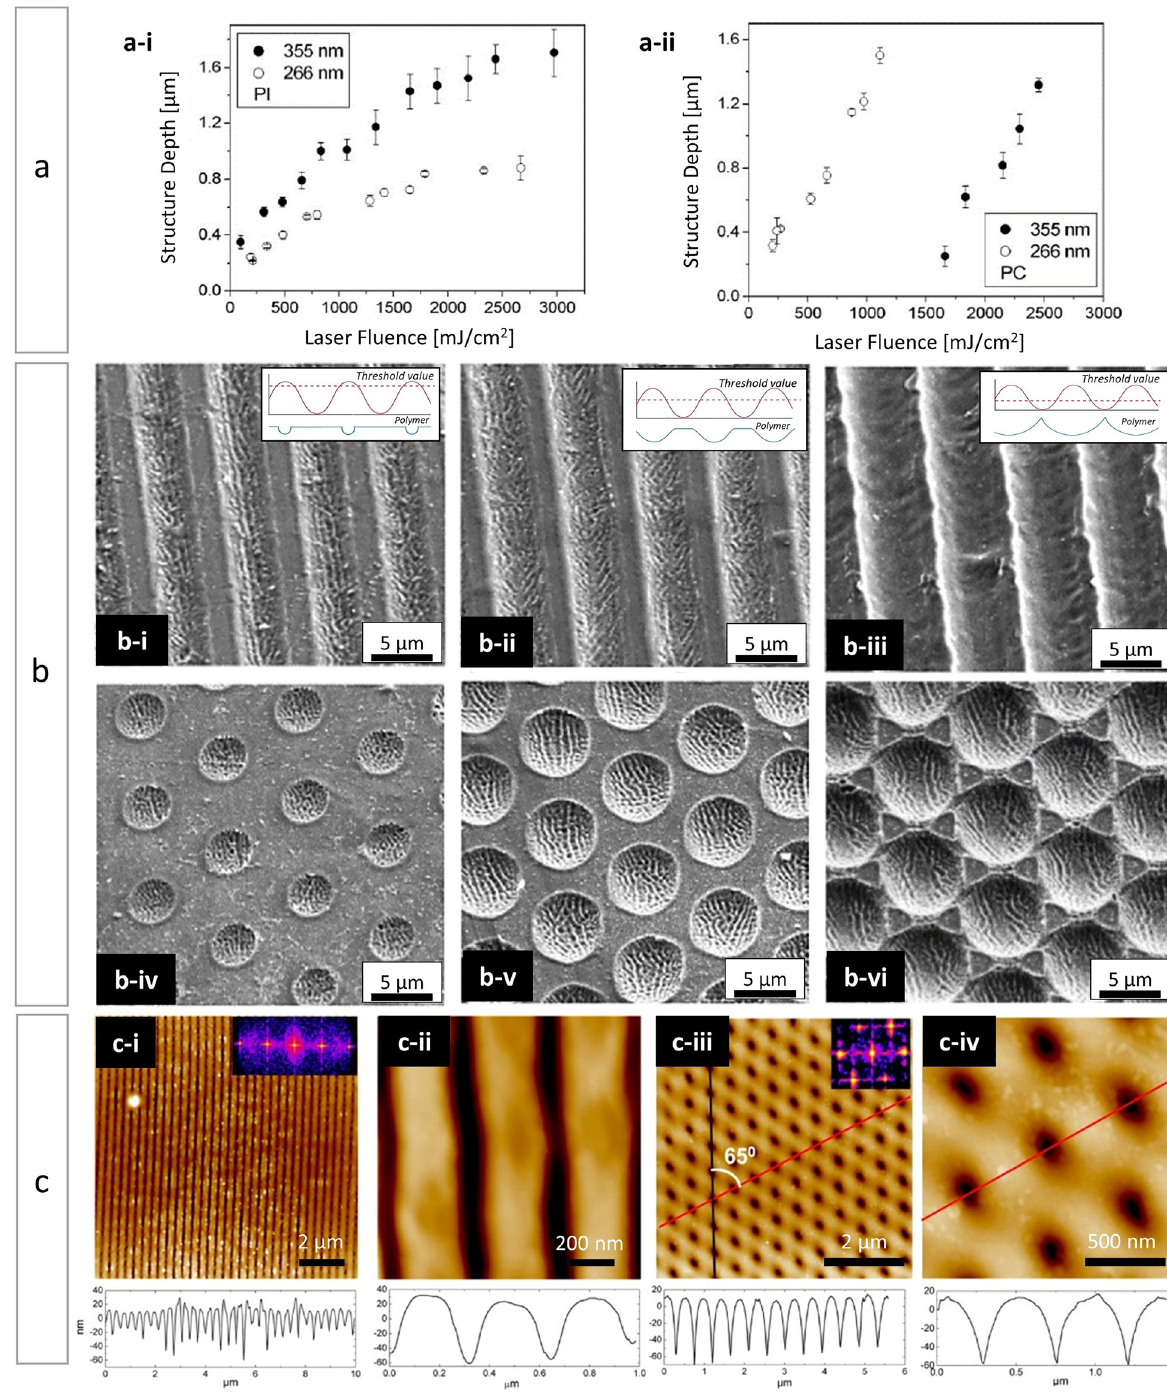
Figure 2: (a) Structure depth as function of the laser fluence for (a-i) PI and (a-ii) PC irradiated with laser radiation of 266 nm and 355 nm of wavelength, respectively. Line-typeinterference pattern.Inall casesthe periodwas 6.2µm.(b) SEMimages illustrating the evolution of thePI micropattern structured by DLIP at 355 nm from sinusoidal to U-shaped pro fi le (scheme in between images where the dotted line is the laser fl uence threshold value) for line-like at fl uence (b-i) 312 mJ cm − 2 , (b-ii) 676 mJ cm − 2 and (b-iii) 1023 mJ cm − 2 ; and pillar-like at fl uence (b-iv) 99 mJ cm − 2 , (b-v) pillar-like at fl uence 277 mJ cm − 2 and (b-vi) 854 mJ cm − 2 . (c) AFM images and corresponding pro fi les (bottom row) of PTT fi lms structured by DLIP at 266 nm using two (c-i, ii) and three (c-iii, iv) interferences laser beams. Figures (a) to (b) adapted from ref. [53] (© 2007 WILEY ‐ VCH Verlag GmbH & Co. KGaA). Figure c adapted from ref. [68] (© 2014 American Chemical